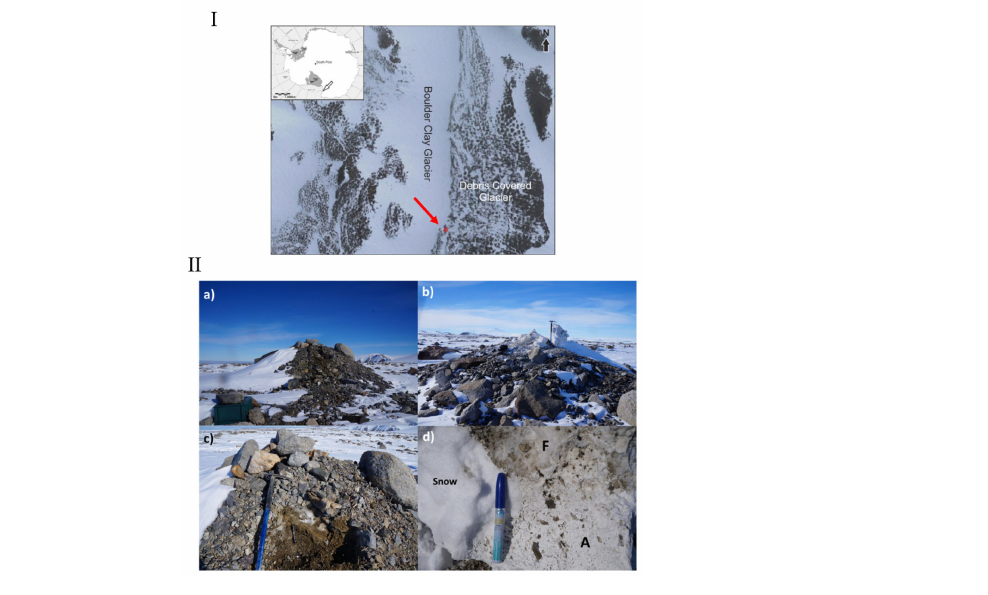
Figure 1. ( I ) Location map. The sampled salt cone is indicated by a red point. Satellite image taken in November 2014 (courtesy Maxar technologies). ( II ) Salt cone photographs. Cone view from the East ( a ) and West ( b ) side of the Boulder Clay glacier. Details of the salt cone ( c ), and fresh (F) and altered (A) crystals ( d